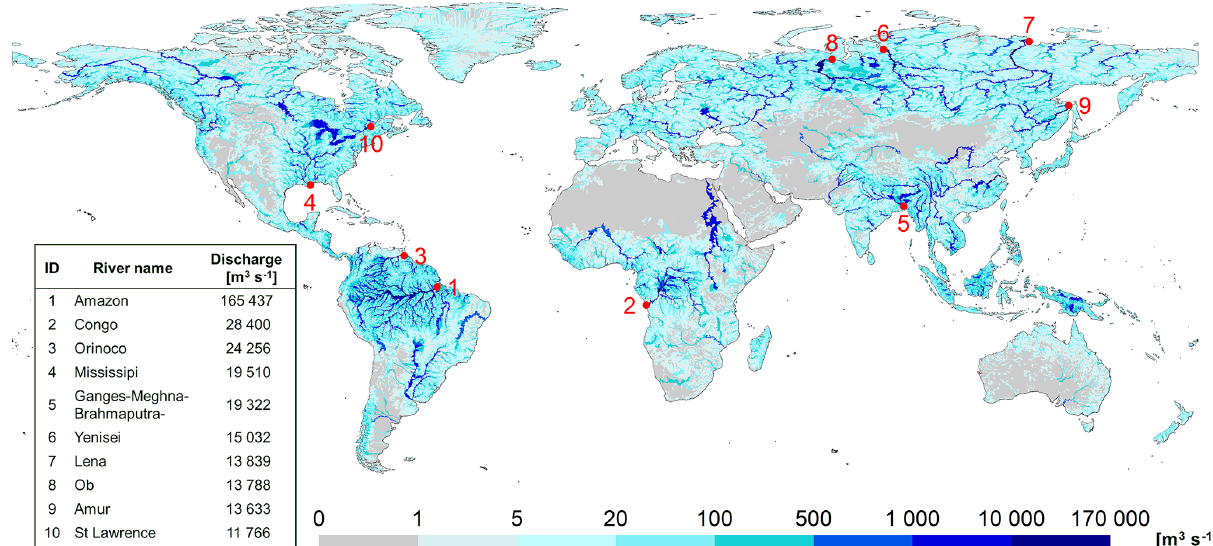
Figure 5. Annual mean of river discharge across the globe for the period 1981–2015 estimated with the WWH version 1.3 catchment model (on average 1020km 2